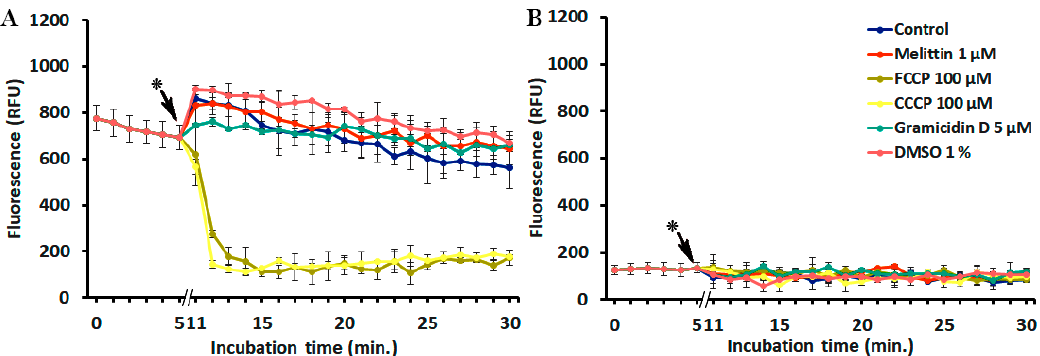
Figure 2. Interference of uncouplers and peptides with the fluorescent dyes. The kinetics of ( A ) diSC 3 (5) ( λ ex = 652 nm, λ em = 672 nm) and ( B ) PI ( λ ex = 535 nm, λ em = 617 nm) are shown in separate graphs for clarity purposes. The time necessary for the addition of peptides and uncouplers (indicated by *) was about 6 min.